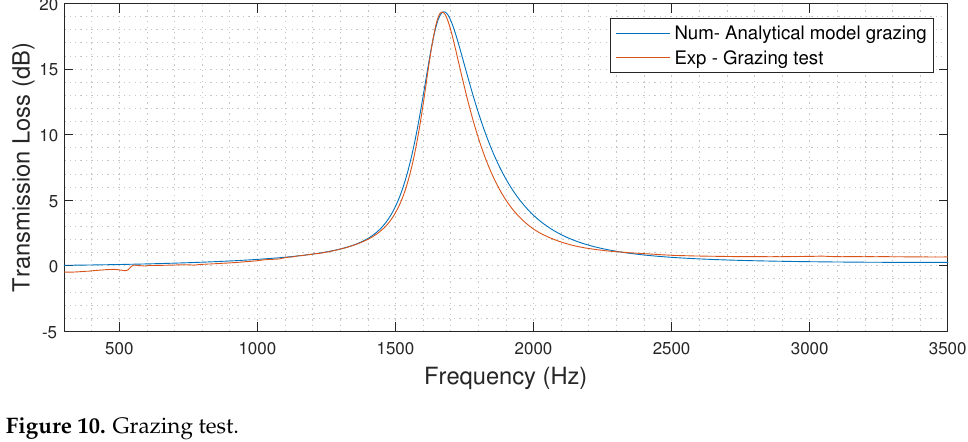
Figure 10. Grazing